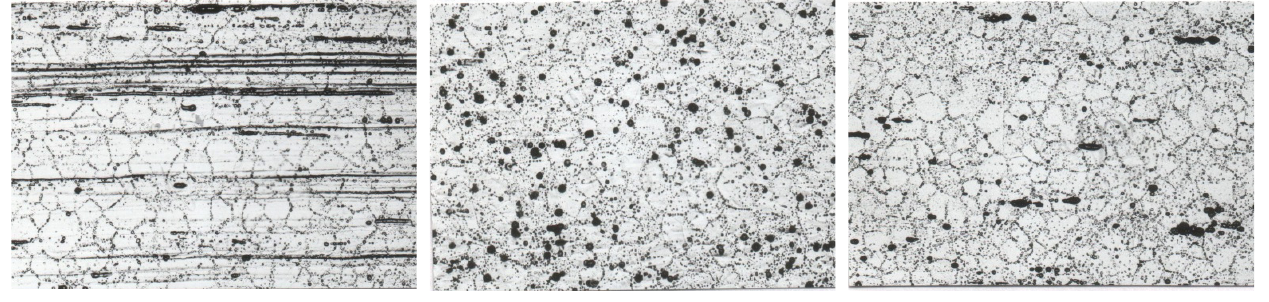
Figure 3c: “5” steel microstructure - Radial section (x 200).